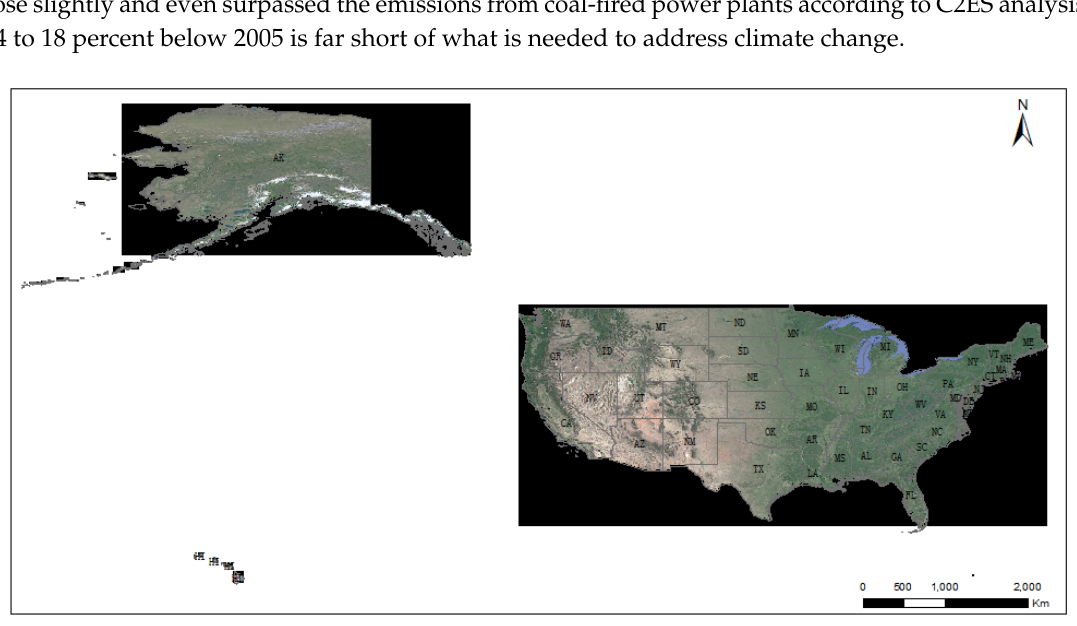
Figure 1. Study area in the United